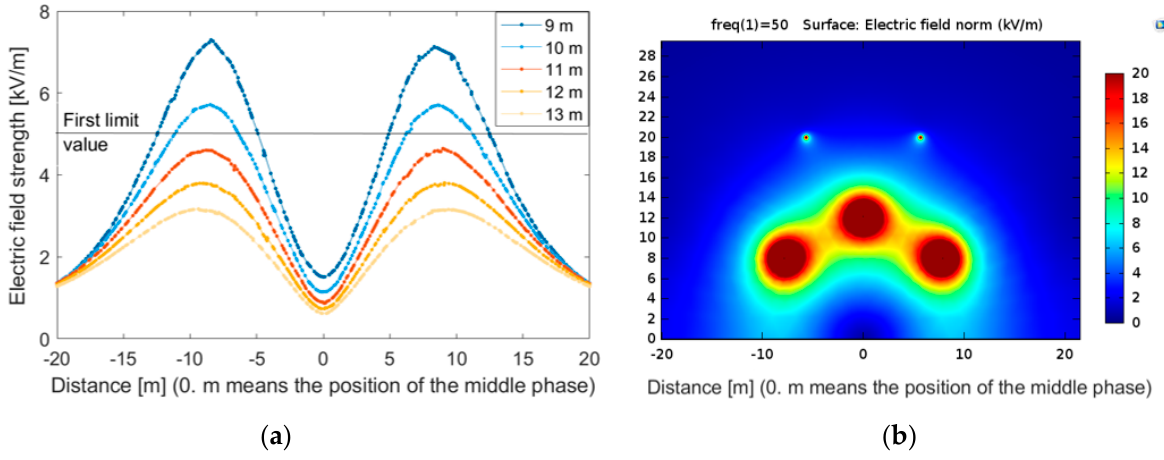
Figure 3. Simulated electric field distribution at 1.8 m height above the ground. ( a ) Results at phase conductor clearance from 9 m to 13 m; ( b ) results at phase conductor clearance of 8 m.